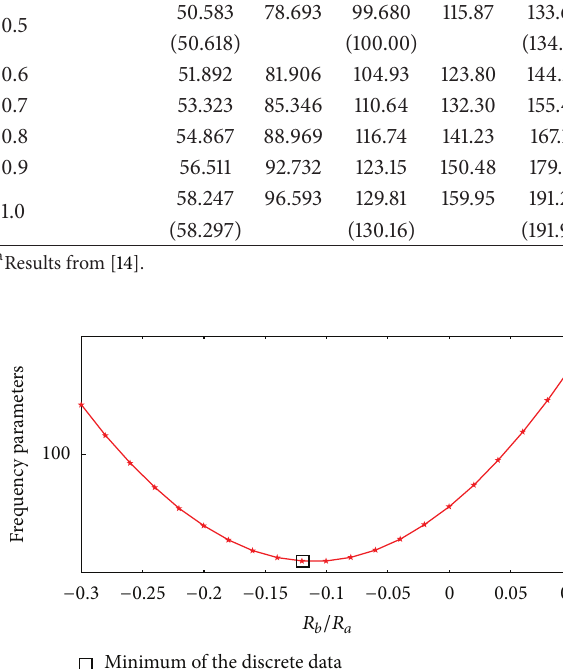
Figure 6: The first mode frequency as a function of curvature ratio for a C-C-C-C shell.